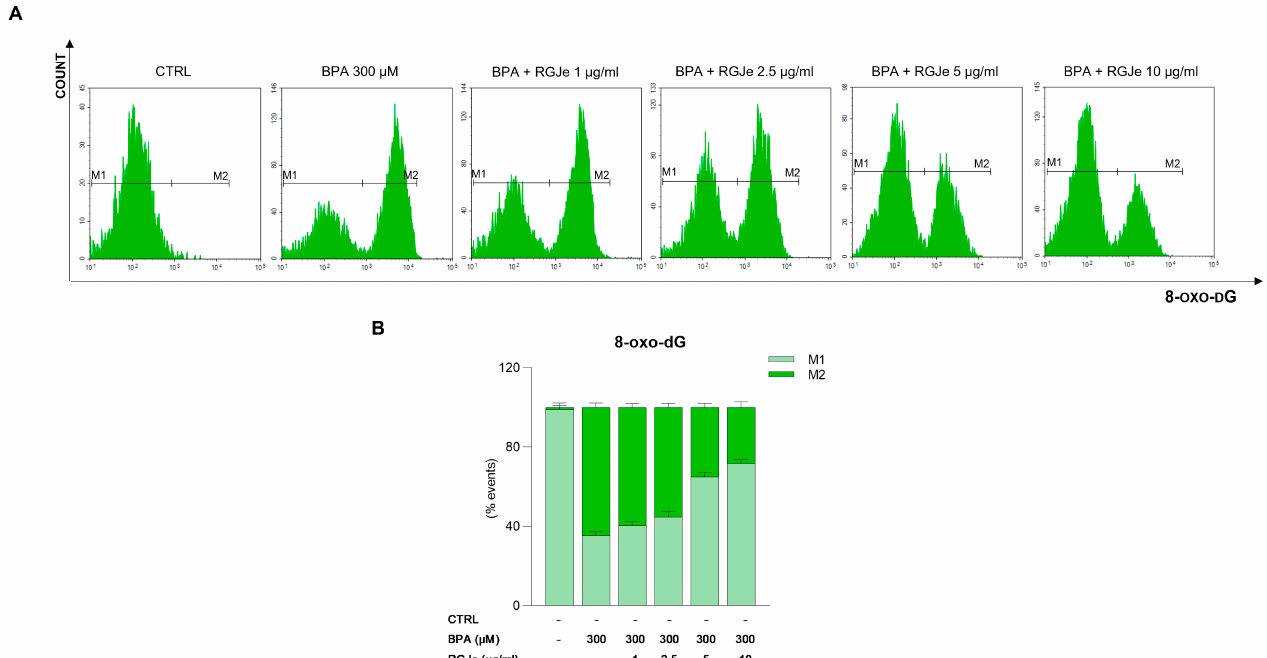
Figure 3. Protective effect of RGJe against the DNA oxidative damage induced by BPA in HUVECs. Levels of 8-oxo-dG were measured by flow cytometry, detecting the emission signals of fluorochrome FITC-labeled avidin. Representative plots of three different experimental sessions performed in triplicate (n = 9) are displayed ( A ). The histogram reports the percentage ± SEM of healthy (non- fluorescent, M1) and damaged (fluorescent, M2) cells ( B ), from three independent experiments performed in triplicate (n = 9).